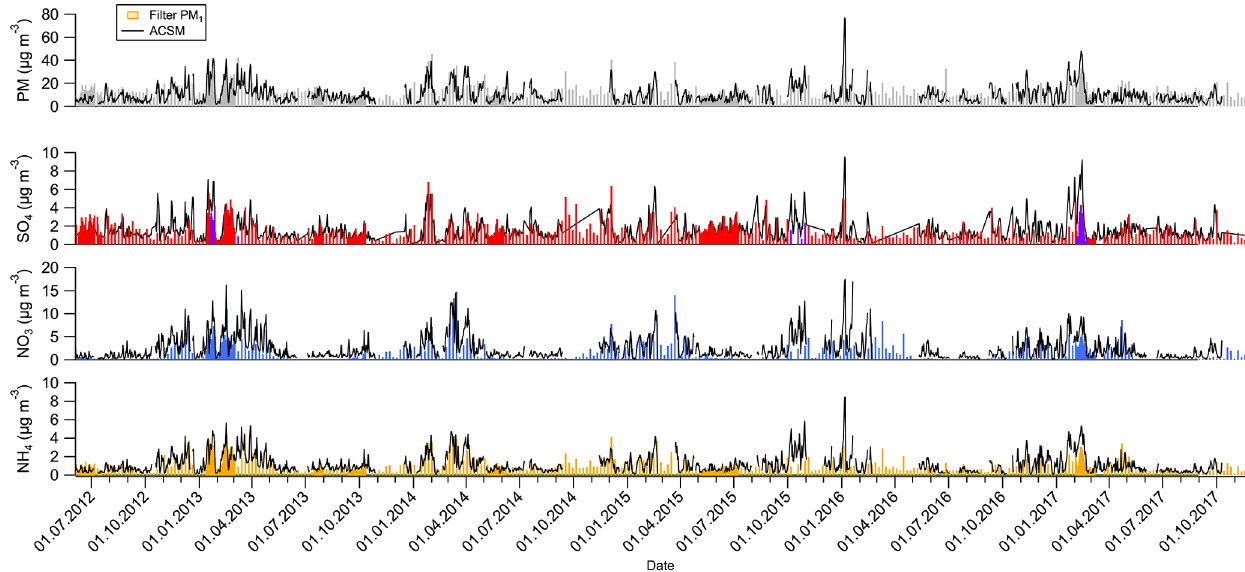
Figure 1. Time series ACSM (daily averaged, black line) and 24h PM 1 filter samples (colored bars) for the total particle mass concentration and the mass concentration of sulfate, nitrate, and ammonium. The particulate matter (PM) corresponds with the sum of ACSM species and eBC PM for the online instrument and the PM 1 filter mass for the offline samples. 1